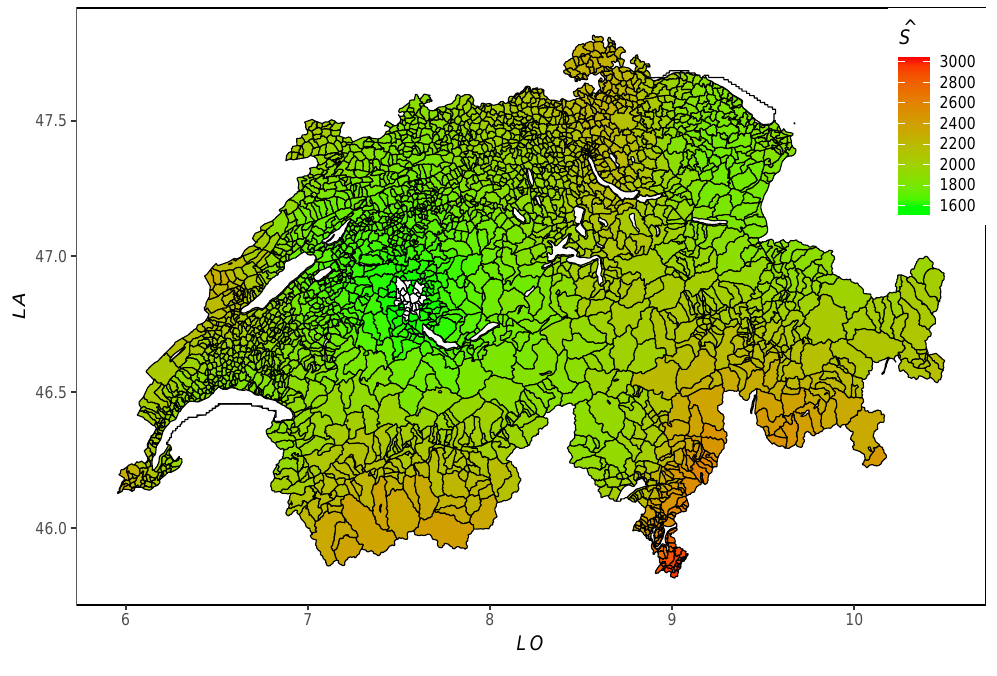
Figure 13. Illustration of the spatial claim severity predictions for the GAM in Equation (1).